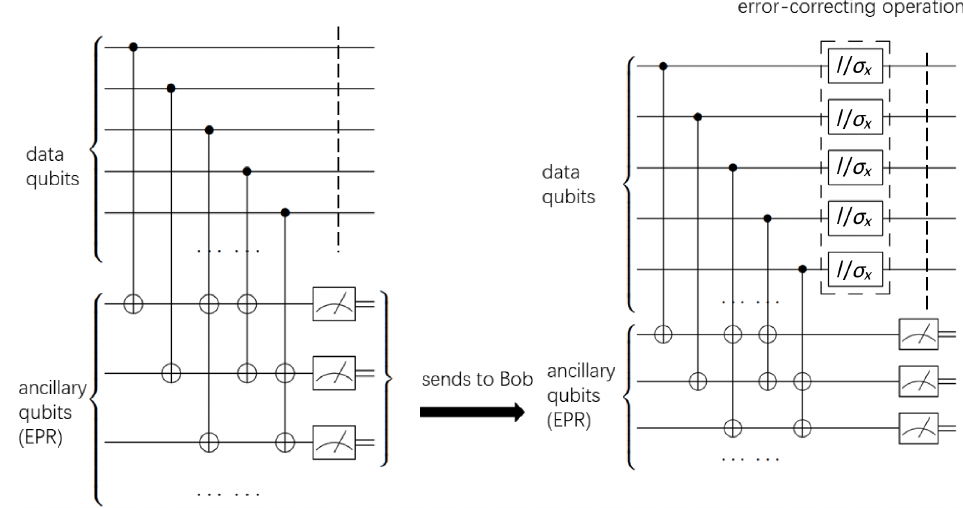
FIG. 5. An illustration of quantum bit-error correction. As an example, the circuit corresponds to the hashing matrix M in Eq. (C1). The i th row of M corresponds to the CNOT control data qubits targeting on the i th ancillary qubit and the j th column of M corresponds to the CNOT target ancillary qubits controlled by the j th data qubit. The measurement result of one ancillary qubit equals the XOR sum of the Z -basis measurement results of the ancillary qubit and its controlling data qubits. By comparing the measurement results, Bob can learn the 1-bit parity information of the data qubits. After knowing enough parity information on the data qubits, Bob can locate the bit errors and correct them with the quantum gate σ x . A similar circuit can be applied for quantum phase-error correction, with additional Hadamard gates according to Fig.